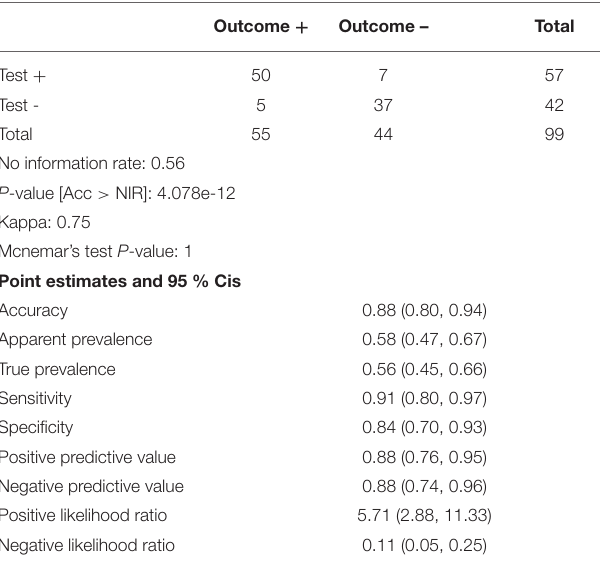
TABLE 4 | Model “psychological support” performance table: the model shows TABLE 3 | Model “anesthesia” performance table: the model shows very high fair accuracy (0.88), optimal sensitivity (0.91), and specificity (0.94). Overall accuracy (0.96), sensitivity (0.91), and specificity (0.97). performance is slightly lower than the “anesthesia” Confusion matrix and statistics for anesthesia prediction model Outcome + Outcome - Total